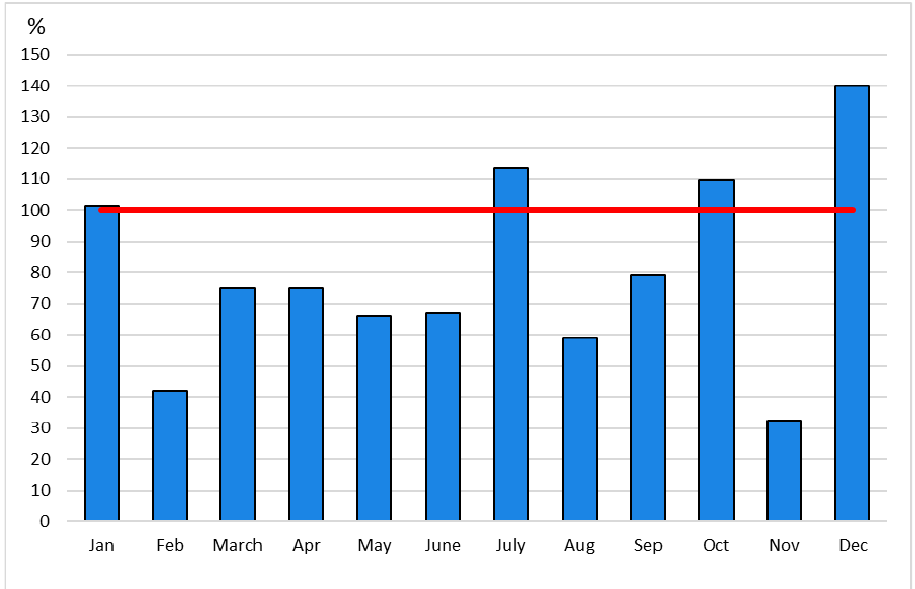
Figure 3. Deviation of monthly precipitation totals [%] in Poland in 2018 from the 1971 – 2000 mean.